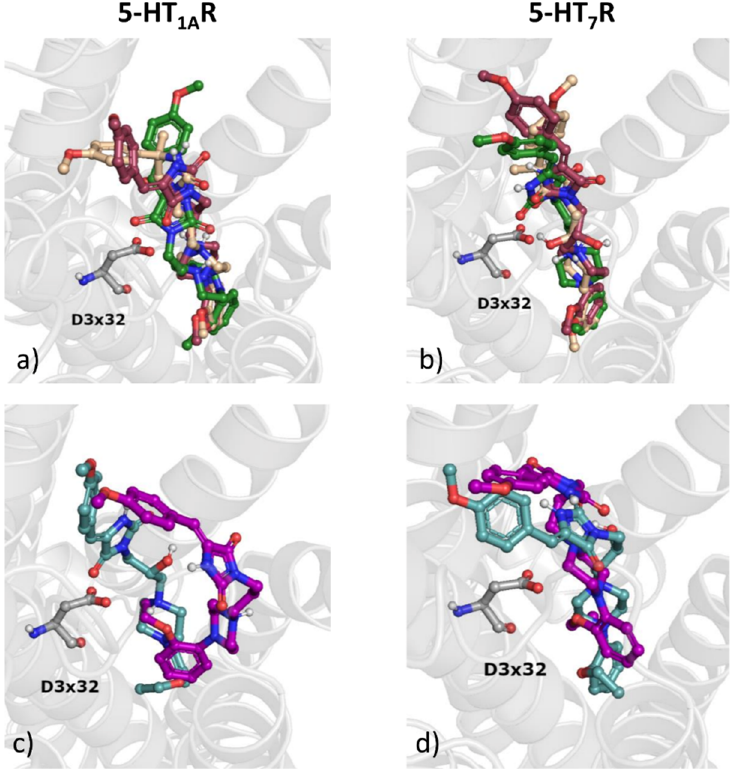
Figure 7. Docking results of selected compounds— 3 —beige, 6 —dark pink, 12 —dark green, 7 —turquoise, 13 —purple to 5-HT 1A R ( a , c ), and 5-HT 7 R ( b , d ).